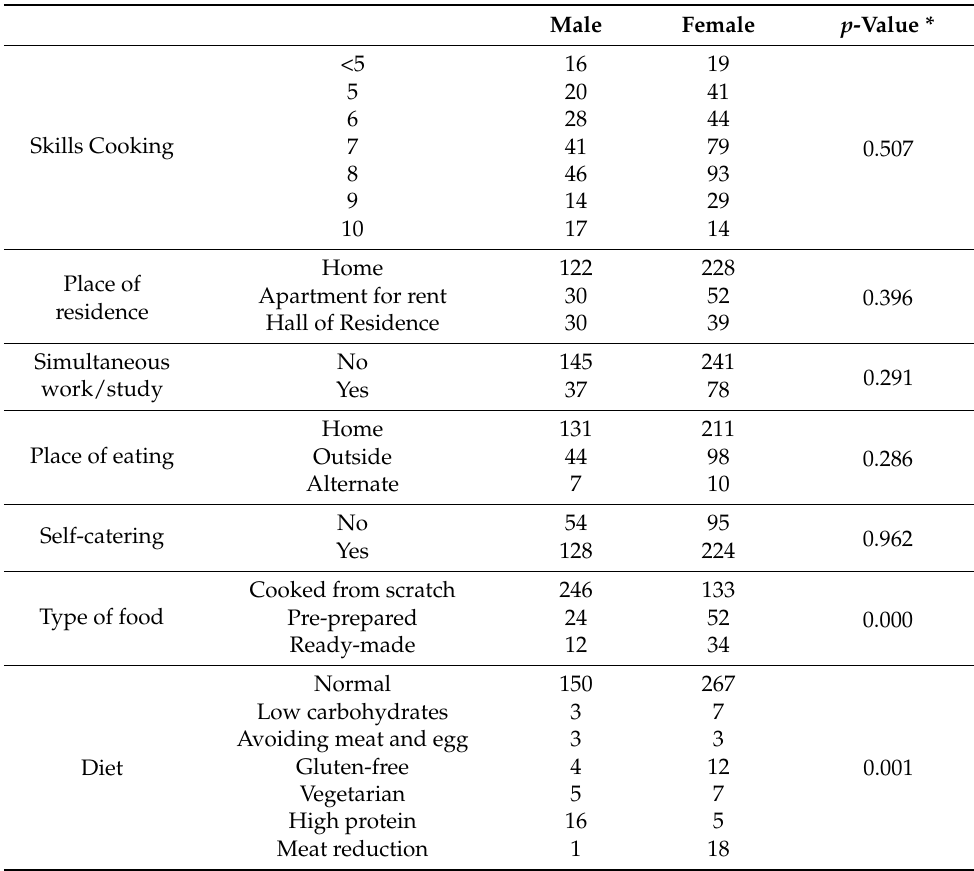
Table 6. Variables related to habitual diet and lifestyle related to